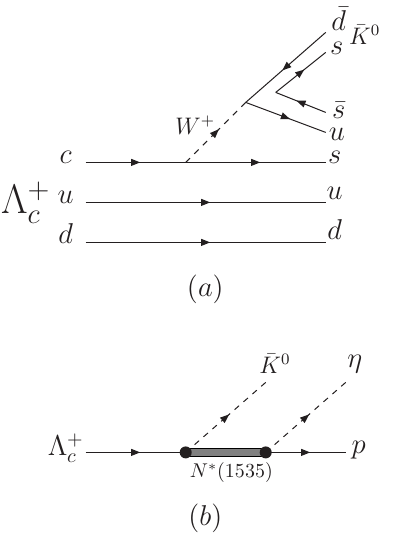
→ ¯ K 0 N ∗ (1535) (a) and c → ¯ K 0 η p decay c